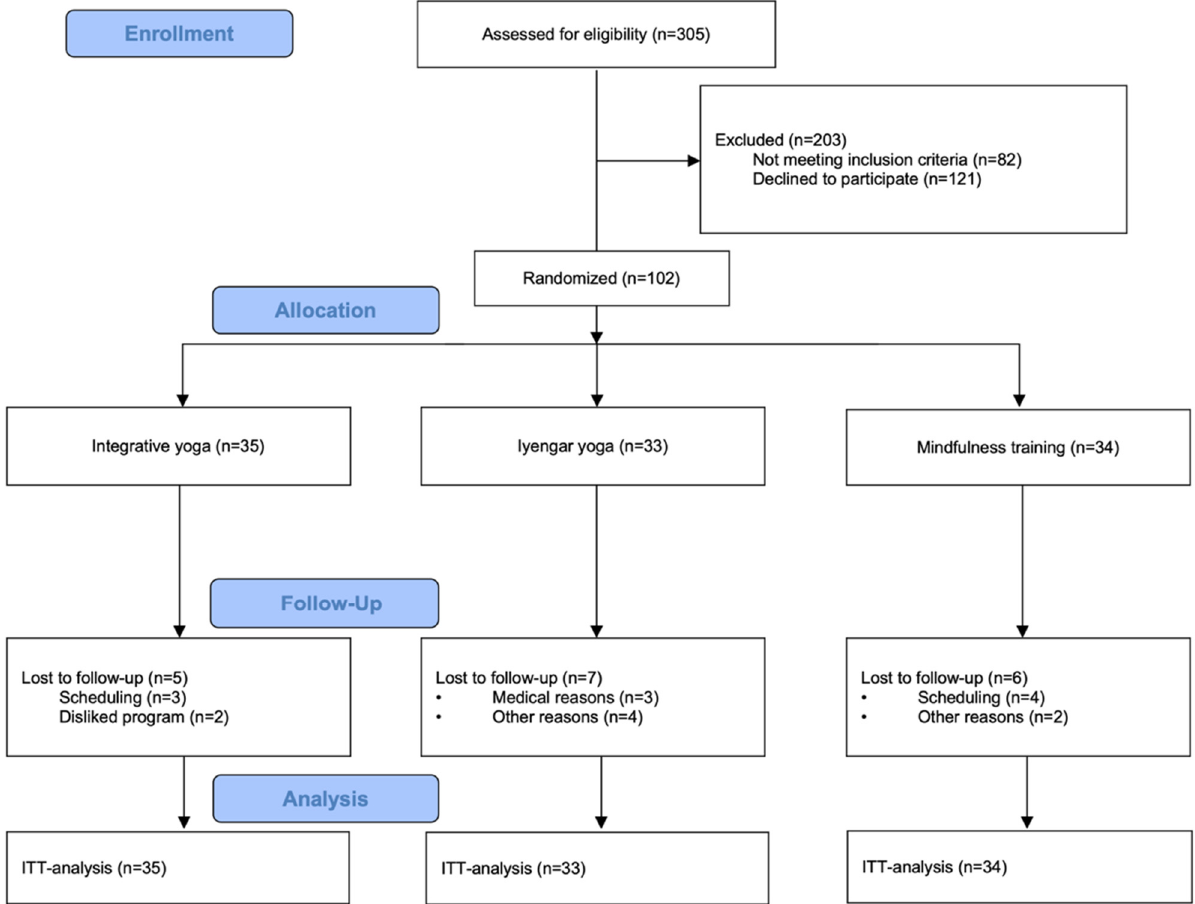
Figure 2. Participant flow.